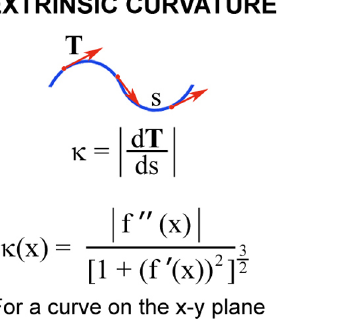
Figure 1. Vessel wall extrinsic curvature is used to describe nonlinearity of blood vessels. For the purpose of this study, extrinsic curvature of a line at a given point is a measure of how quickly the curve changes direction at that point and, therefore, is defined as the magnitude of the rate of change of the unit tangent vector T with respect to the arc length s. Thus, for the curve on the x-y plane, the extrinsic curvature k(x) is calculated by the formula shown.